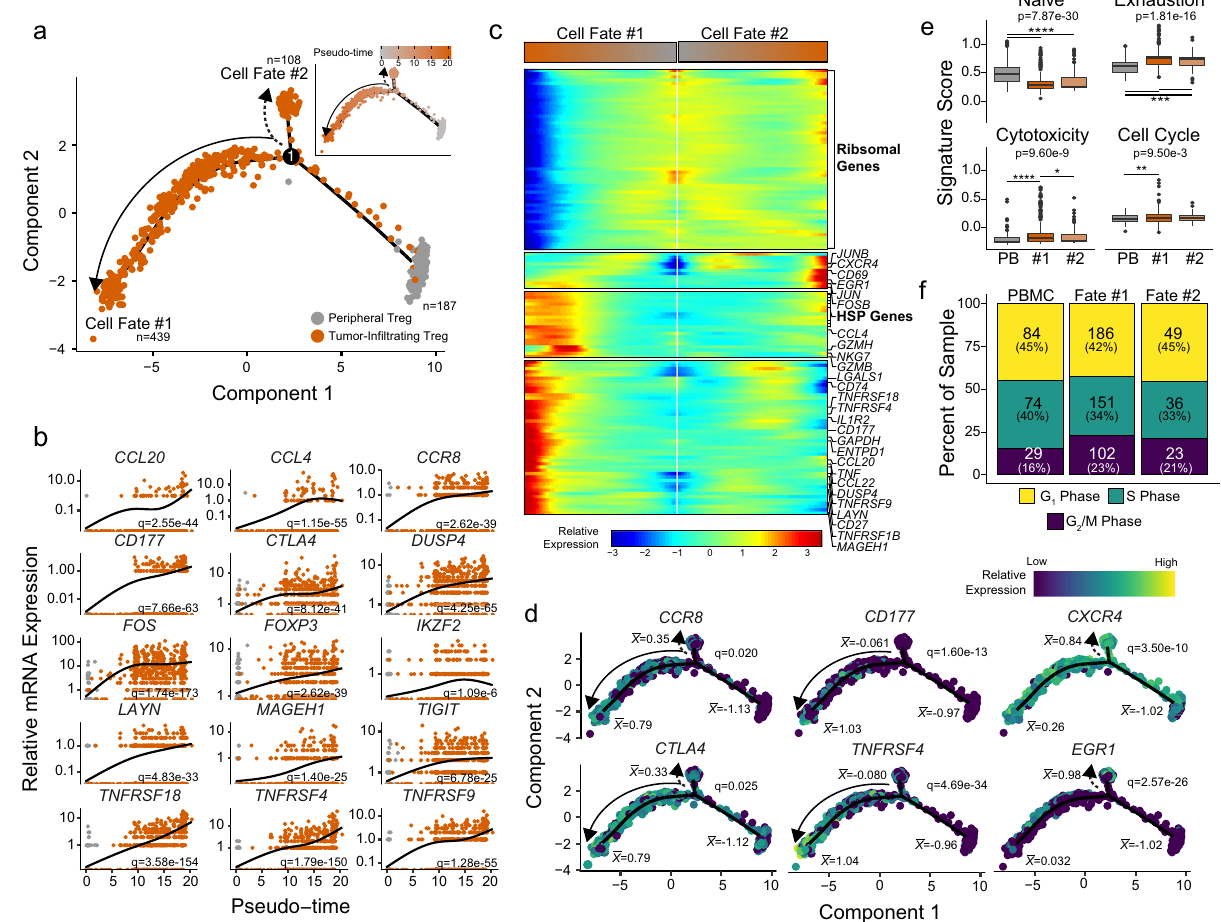
Fig. 2 Bifurcation in the transcriptional state of TI Treg cells reveals a more suppressive cell fate. a Trajectory manifold of Treg cells from the ccRCC using the Monocle 2 algorithm. Solid and dotted lines represent distinct cell trajectories/fates de fi ned by expression pro fi les. b Pseudotime projections of transcriptional changes in immune genes based on the manifold. The signi fi cance was determined based on differential testing relative to the site of origin which was also used to generate pseudotime and adjusted for multiple comparisons. c Expression heatmap of signi fi cant (q < 1e-6) genes based on branch expression analysis comparing the two TI cell fates. The genes in the heatmap were also used in the ordering of the pseudotime variable. d Cell trajectory projections of transcriptional changes in immune genes based on the manifold. Signi fi cance based on differential testing between the fi rst and second cell fates of TI Treg cells. (cid:1) x denotes the scaled mean mRNA levels at each pole of the manifold. e Gene set enrichment analysis of the poles of the trajectory manifold. Boxplots were drawn for values between 25th and 75th percentile with median value lines. Outlier values were graphed as individual points for values 1.5 times the interquartile range. P -values are based on one-way ANOVA with individual comparisons corrected for multiple hypothesis testing using the Tukey HSD method. f Results of the cell cycle regression analysis of single cells for each cell fate using the Seurat R